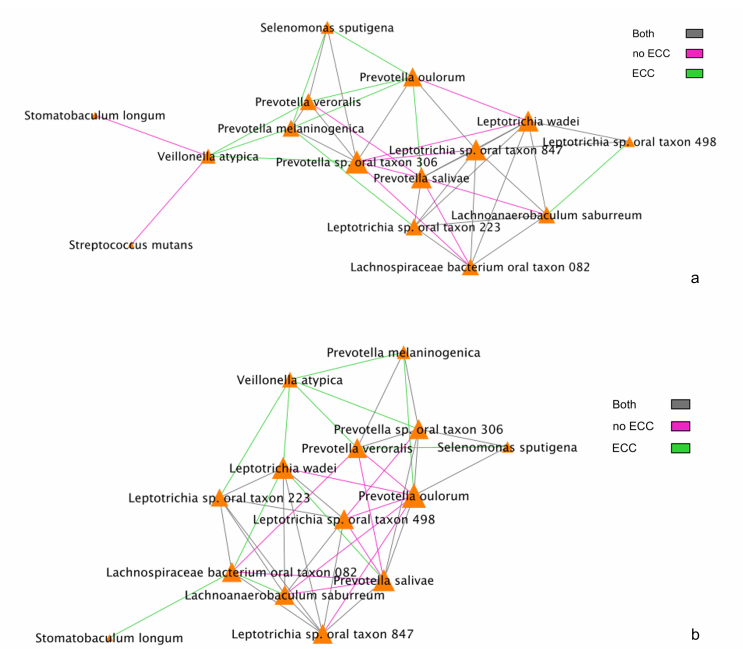
Figure 5. ( a ) BZINB correlations between species. The strongest 30% of correlations are included in the diagrams, and the color of the lines represents whether the correlation was strong in one or both of the health/disease groups. ( b ) Spearman correlations between species. The strongest 30% of correlations are included in the diagrams, and the color of the lines represents whether the correlation was strong in one or both of the health/disease